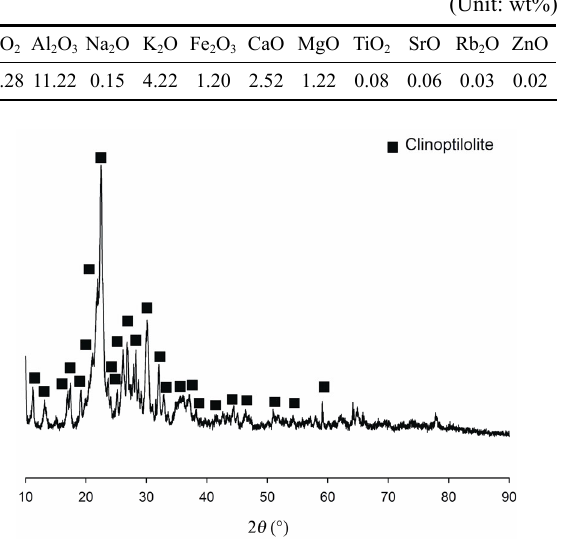
Fig. 1 XRD analysis of provided zeolite sample from Eti Mine Company,